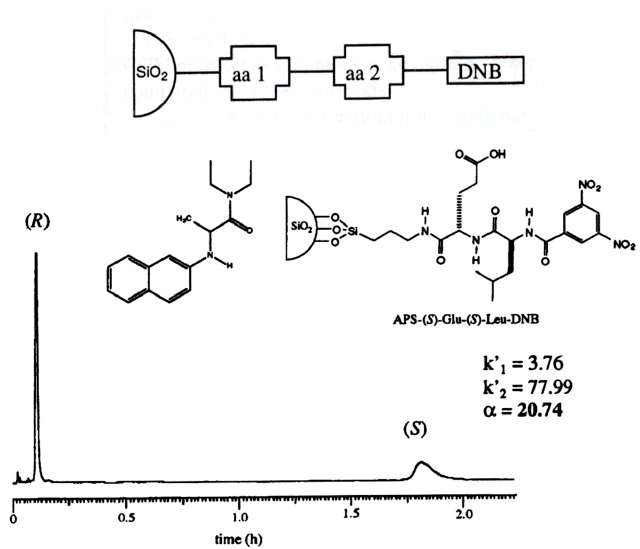
Figure 15. Top : DNB-dipeptide libraries used as CSP for the enantioseparation of N -(2-naphthyl)alanine diethylamide. Bottom : The optimized aminopropylsilica-bonded L -Glu- L -Leu-DNB selector enantioseparates the test racemate with high enantioselectivity. Column: 4.6 mm × 250 mm I.D., eluent: 2-propanol/ n -hexane (20/80 v/v ). Reprinted with permission from [61]. Copyright (1999) American Chemical Society.